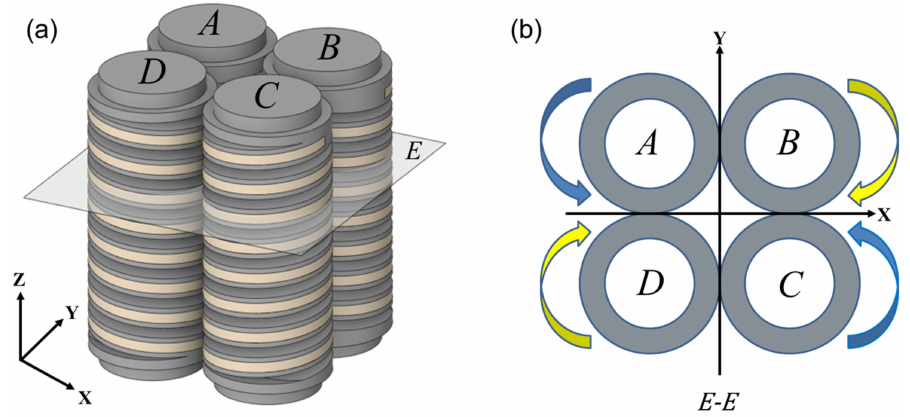
Figure 2. Design of a pneumatic soft wrist: ( a ) a soft wrist module; ( b ) cross-section of the soft